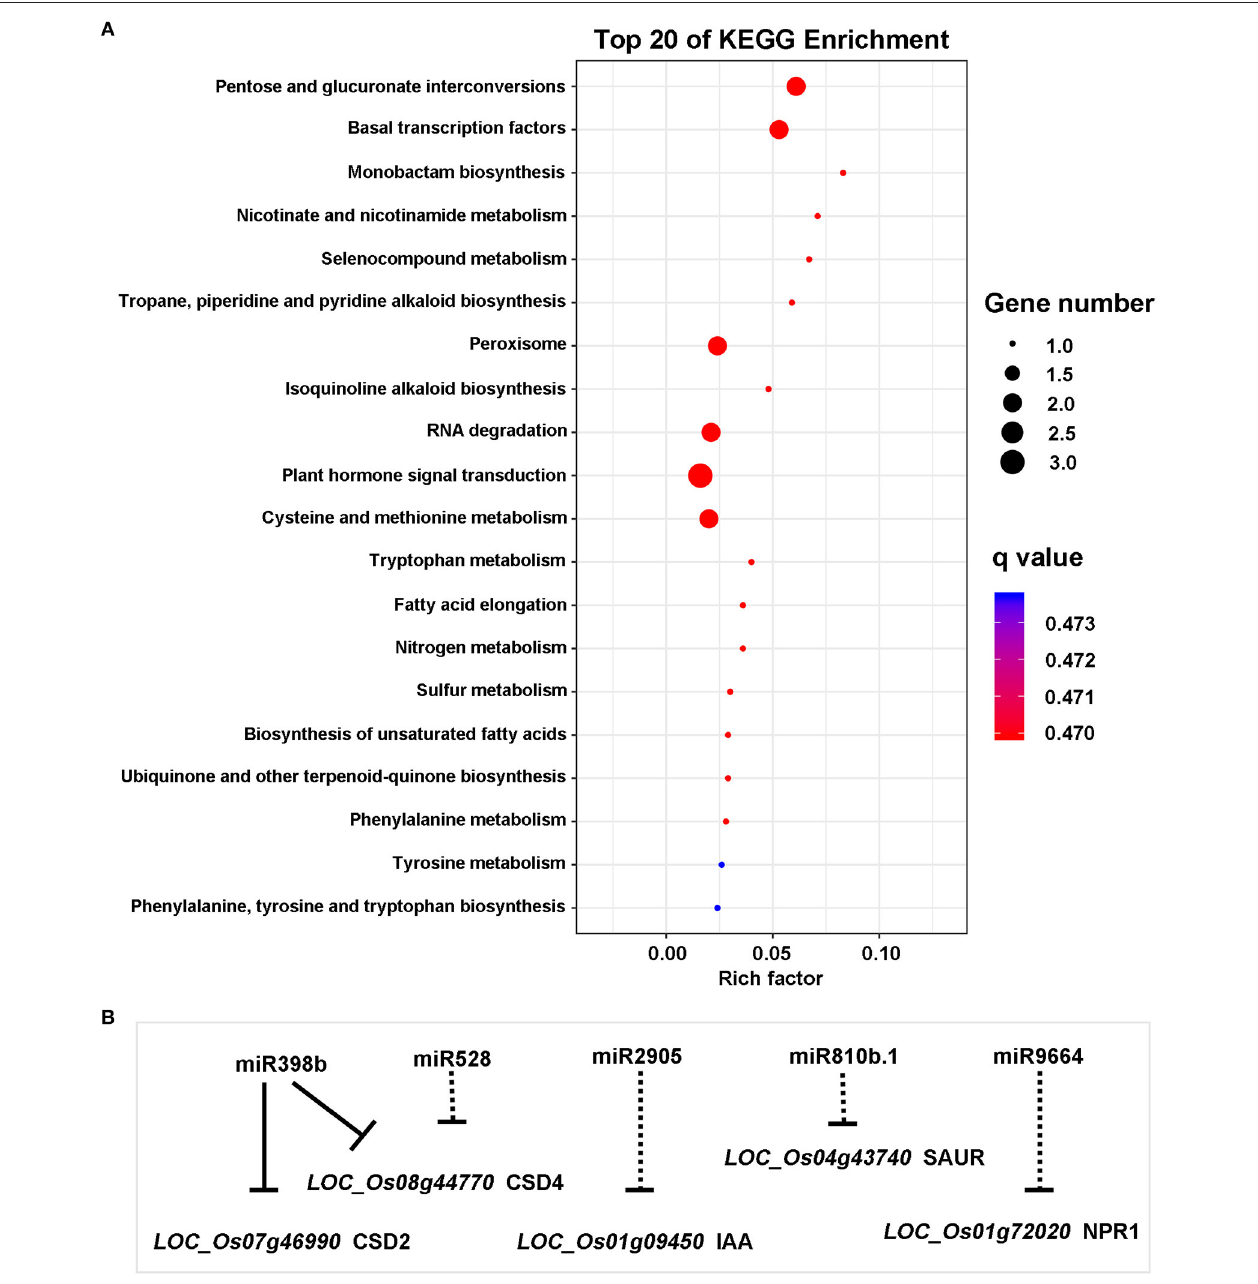
FIGURE 4 | Analysis of predicted target genes. (A) The top 20 Kyoto Encyclopedia of Genes and Genomes (KEGG) pathway terms. The ordinates in the figure are the KEGG’s B-level categories, which is the specific pathway name. The abscissa is the rich factor, which refers to the degree of enrichment. The size of the circle represents the number of genes. The color represents the Q -value (corrected- P -value). (B) miRNAs and the corresponding target genes (solid line)/predicted target genes (dotted line) in the main disease resistance pathway.